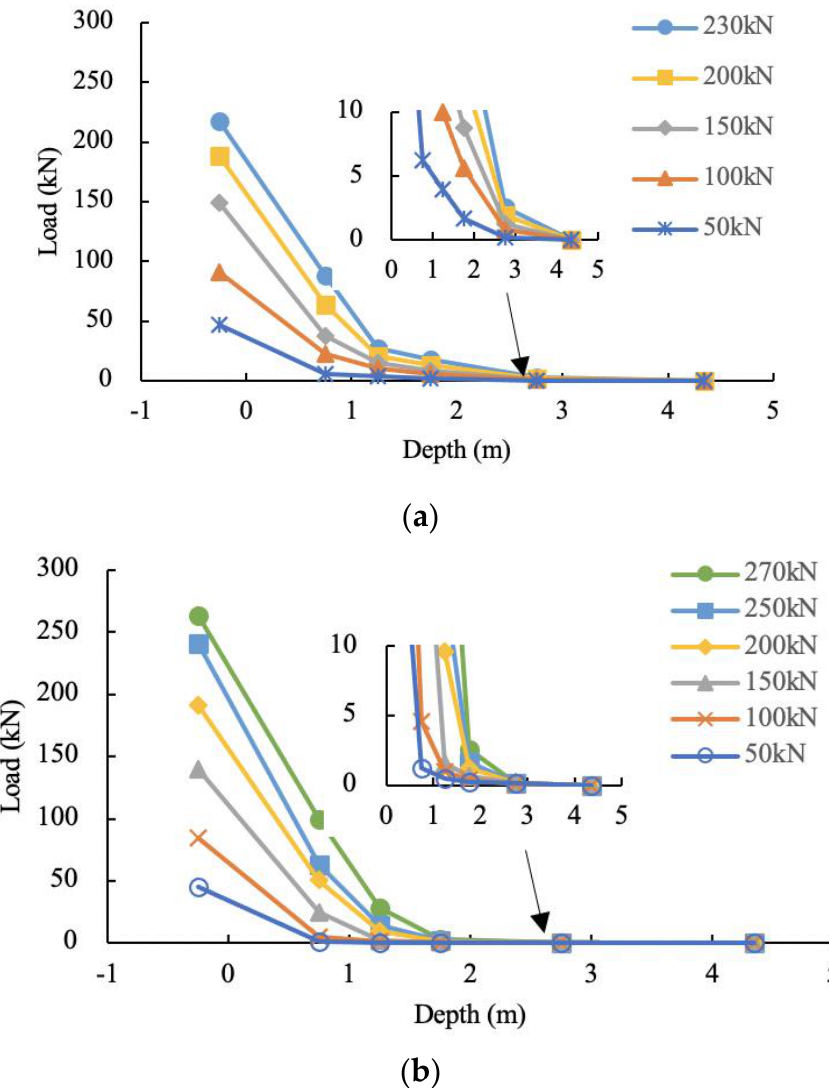
Figure 13. Curve of the bar anchorage depth. ( a ) Steel Bar. ( b ) GFRP Bar. In summary, the force in reinforcing soft rock slope with steel bar is mostly borne by the bar body itself and the bar body interface, while the force in strengthening soft rock slope with GFRP bar is mostly borne by the bar and the grouting body. Hence, the anchorage structure of steel bar in soft rock can generate larger interfacial relative displacement with the loading increasing than the GFRP bar in the anchorage section, even though the elastic modulus of steel is much larger than GFRP. In the expansive soil, the anchorage structure deformations of steel and GFRP bar are almost the same because of the weaker bond at the interface of the grouting body and the surrounding soil than that of the bar interface.